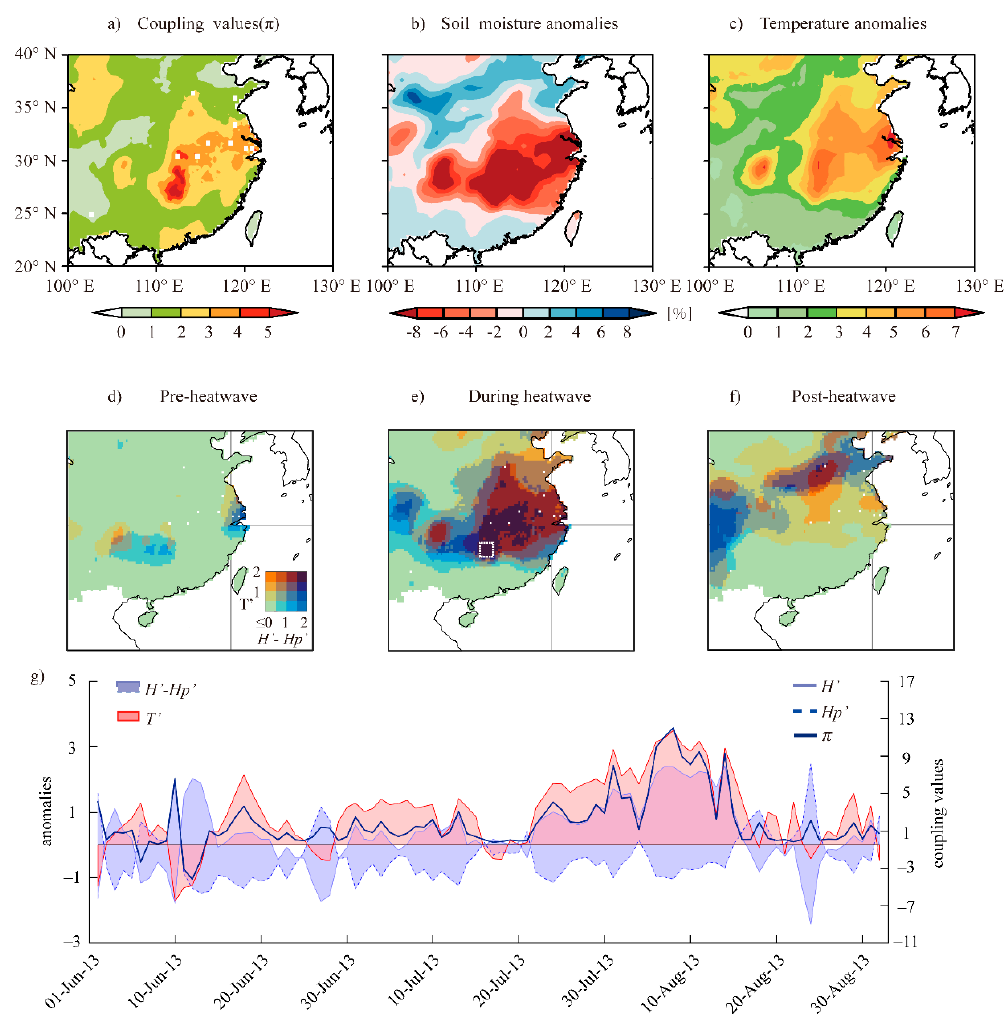
Figure 5. The soil moisture–temperature coupling and related processes during the summer heatwave of Southeast China during 24 July–16 August 2013. ( a ) The coupling metric π ; ( b ) the soil moisture anomalies and ( c ) the temperature anomalies, referring to the multi-year average of 1980–2013; ( d ) pre-heatwave (12–23 July); ( e ) the occurrence of the heatwave (24 July–16 August); ( f ) the days after the heatwave (17–28 August); ( g ) daily time series of T (cid:48) , H (cid:48) , H p , and the coupling metric π .